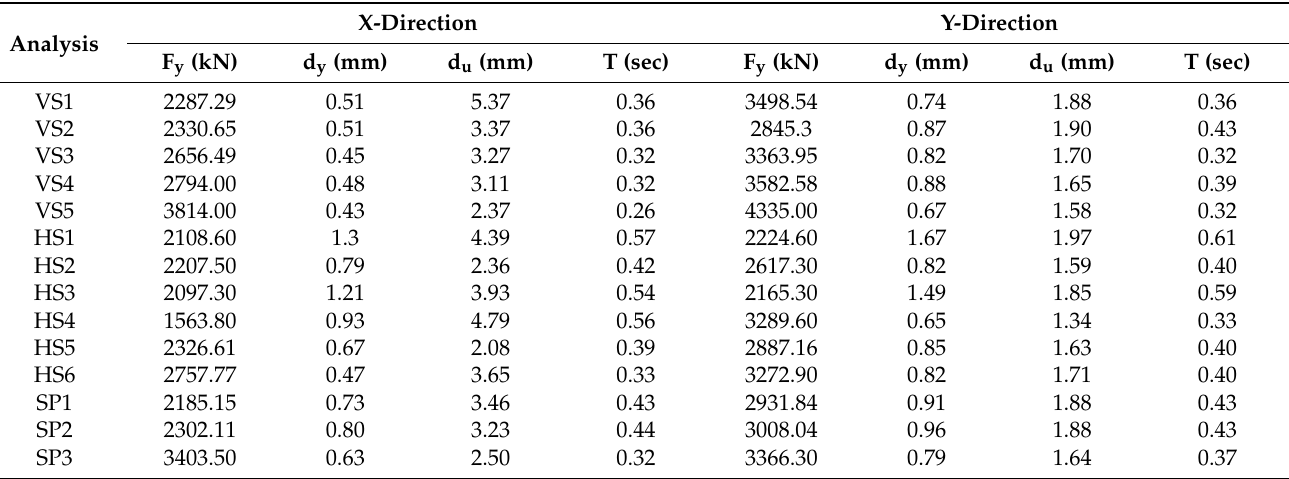
Table 3. Properties of the capacity curves.